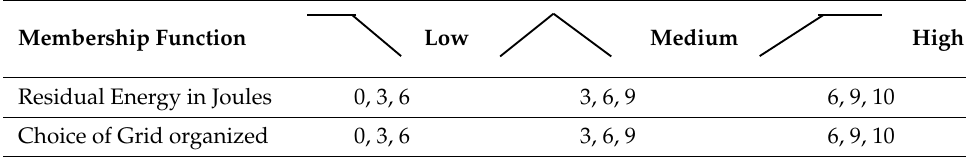
Table 1. Membership function for residual energy and grid organized choice.